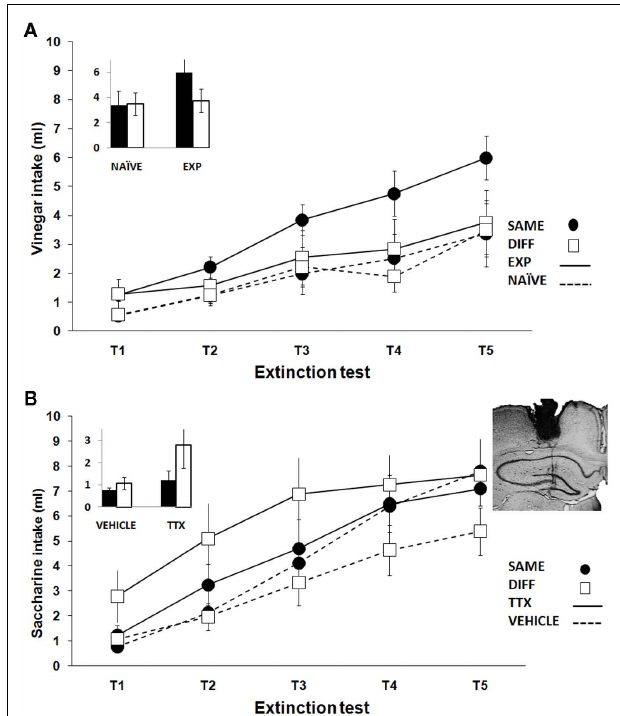
FIGURE 2 | Mean ( ± SEM) taste solution intake by the aged groups SAME and DIFF using a long-habituation protocol for exploring the hippocampal-dependent time-of-day modulation of taste learning. (A) Reinstatement of the hippocampal adult pattern of results by previous training (EXP groups). Naïve animals (NA¨lVE groups) did not exhibit modulation of learning by time-of-day. (B) Emergence of the opposite non-hippocampal pattern of results in trained groups receiving tetrodotoxin (TTX groups) injection in the dorsal hippocampus.Vehicle injected groups (VEHICLE) did not differ between them.The inset highlights the key comparisons on the retention test. A cresyl violet-stained coronal section shows a representative injection needle trace indicating the infusion target area in the dorsal